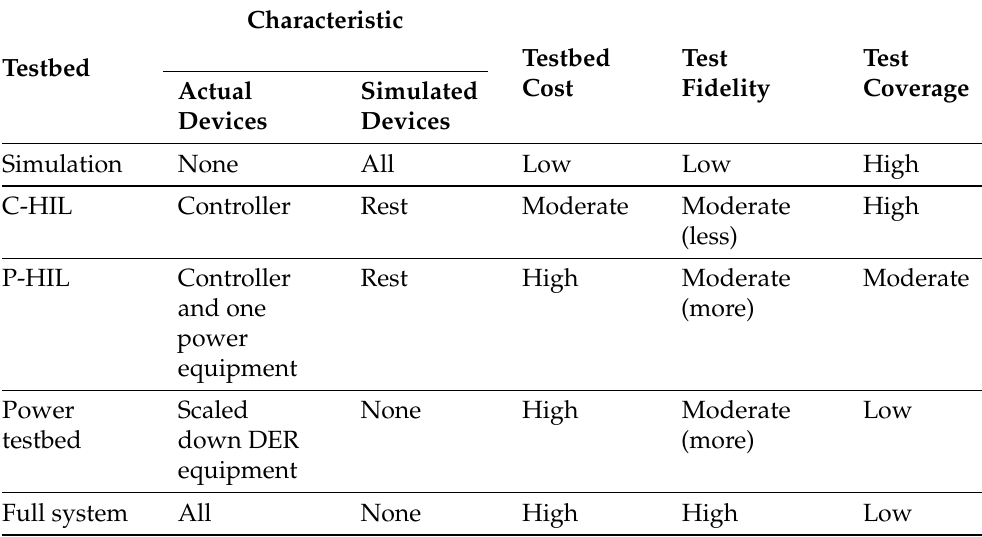
Table 6. Validation platform